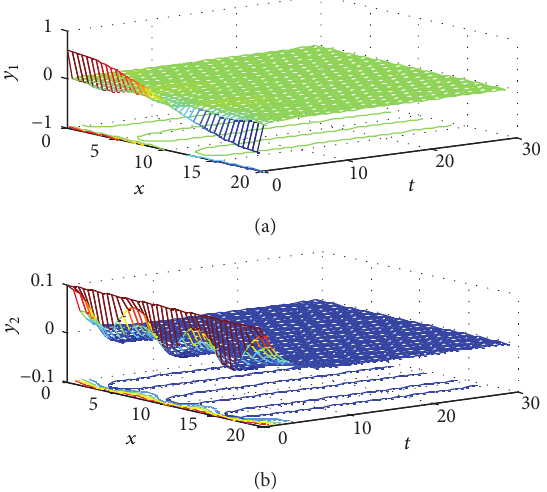
Figure 3: Closed-loop profiles of evolution of 𝑦 1 (𝑥, 𝑡) and 𝑦 2 (𝑥, 𝑡) .